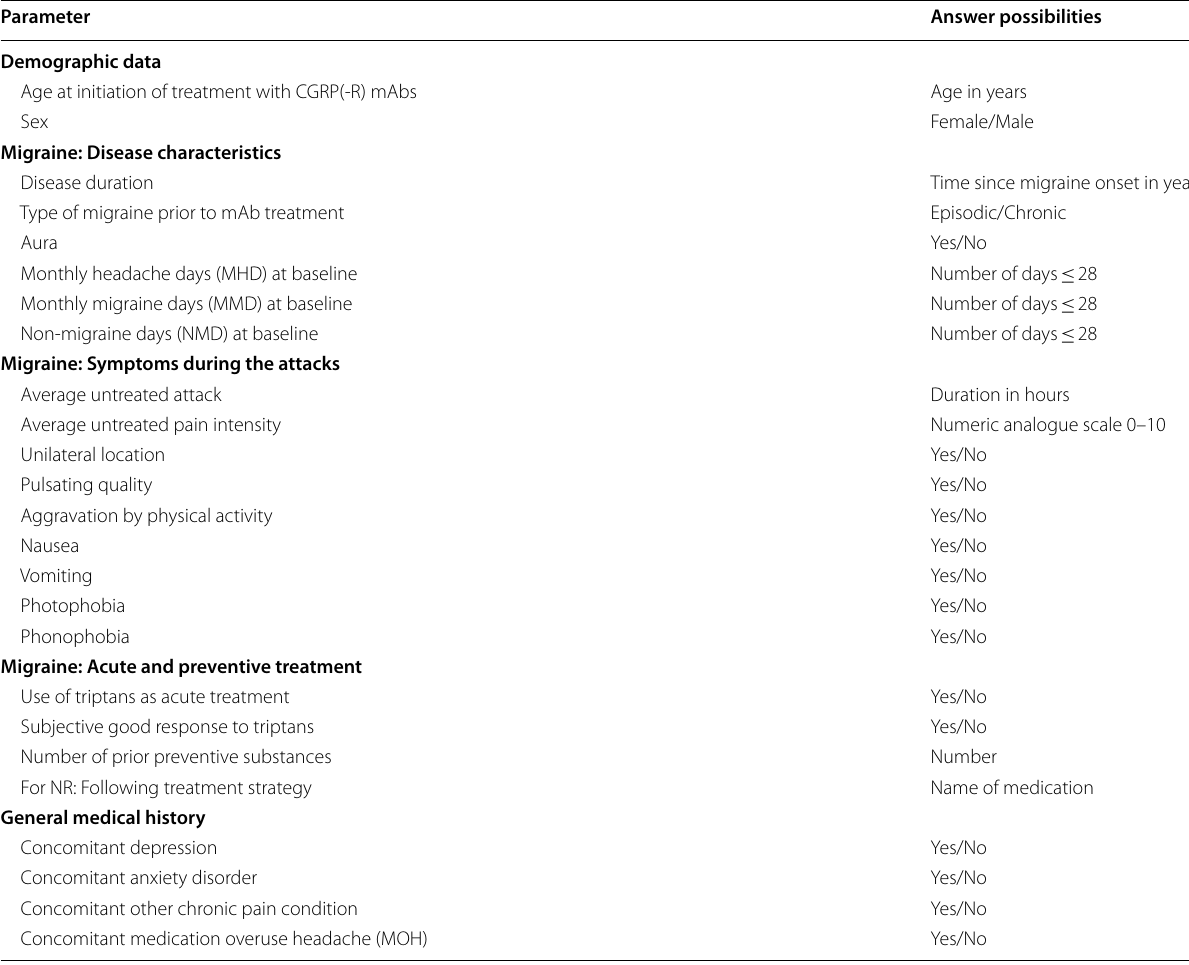
Table 1 Collected parameters in Super-Responders (SR) and Non-Responders (NR) with the respective answer possibilities Parameter Answer possibilities Demographic data